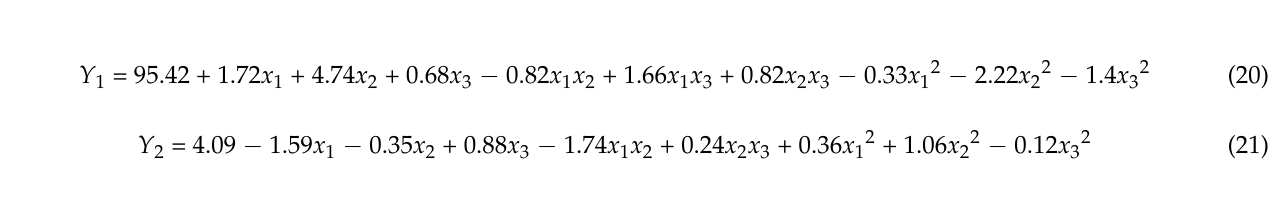
Table 4. Variance analysis of the regression